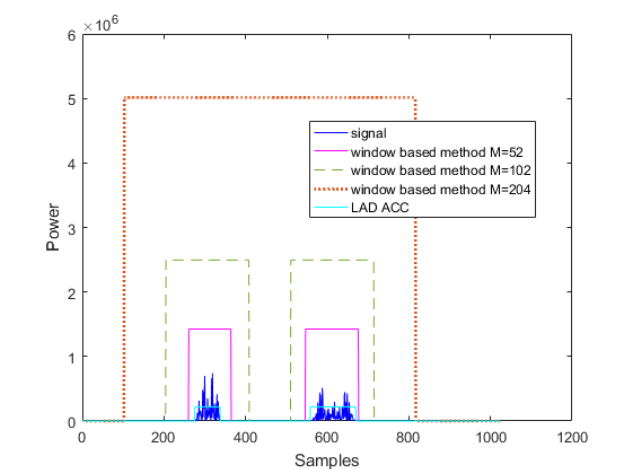
Figure 8. One snapshot of two simulated signals with 5% and 10% bandwidth. M = 52 (optimal for 5% BW signal), 102 (optimal for 10% BW signal), and 204